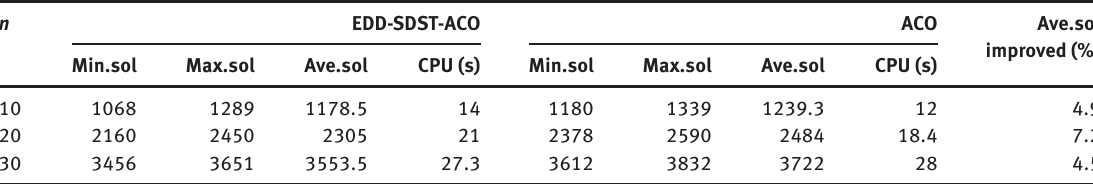
Table 7: Comparison between the Results of EDD-SDST-ACO Algorithms and ACO.